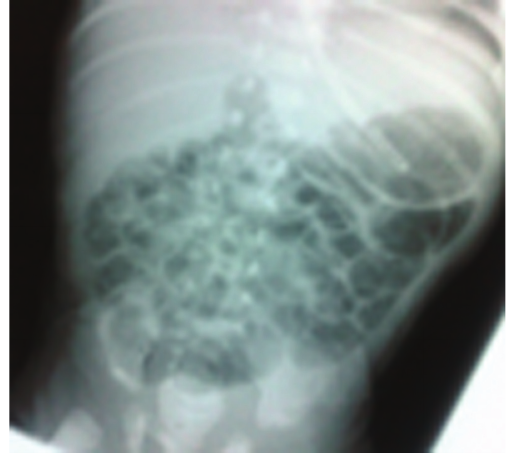
Figure 1: Abdominal radiograph that shows small intestine dilated loops in central position and a gasless distal part of intestine.